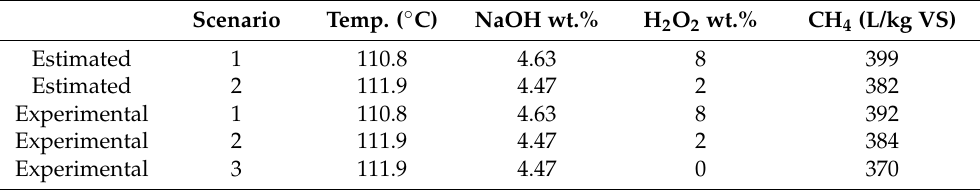
Table 5. Estimated model and laboratory results for the optimal